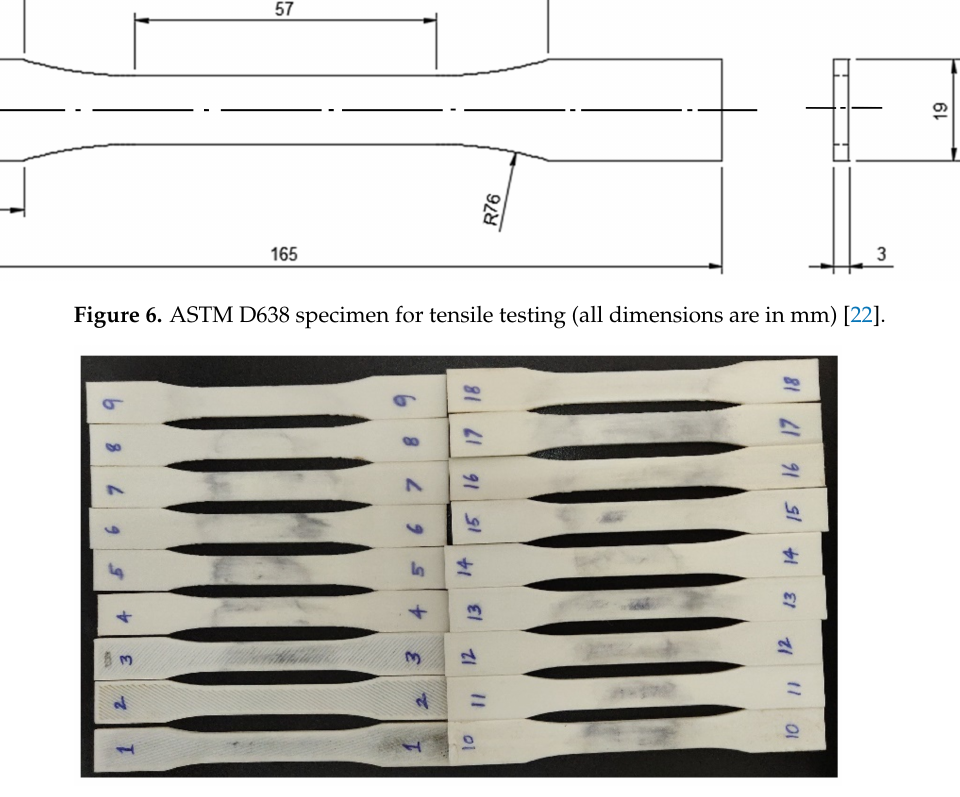
Figure 7. Printed specimens for tensile test as per the experimental